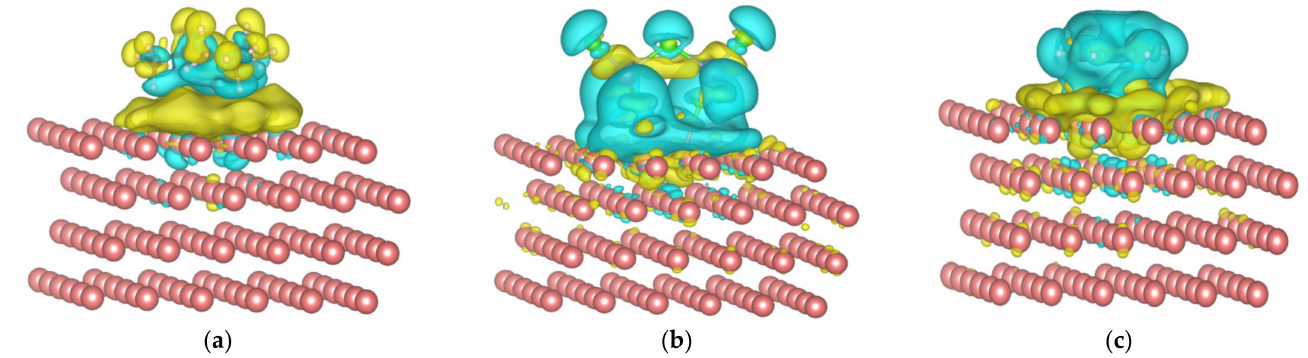
Figure 9. Differential charge density diagram of molecules or ions on the surface of Cu(111) for ( a ) Et 3 NH + ; ( b ) Al 2 Cl 7 − and ( c ) C 6 H 6 . The yellow color represents the area of charge accumulation and blue color represents the area of charge